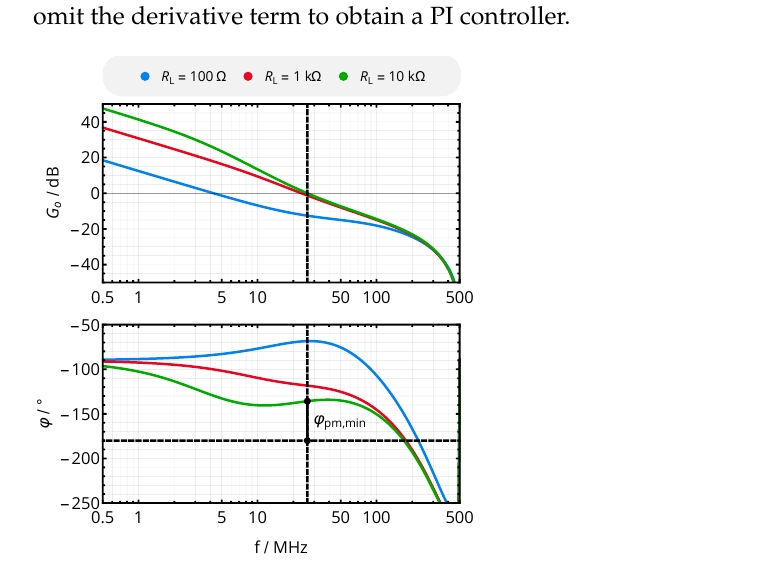
Figure 8. Bode plot of the open-loop transfer function G o [ e j 2 π f 0 ] for M 12 = 10nH, the control parameters ( K P , T I , T D ) = ( 0.7,0.01s,0s ) and different DC load resistances R L,2 , resulting in the minimal phase margin of 44 ◦ for R L,2 = 10k Ω